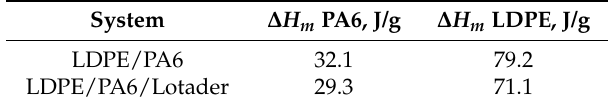
Table 2. Melting enthalpies of the PA6 and LDPE phases (anisotropic